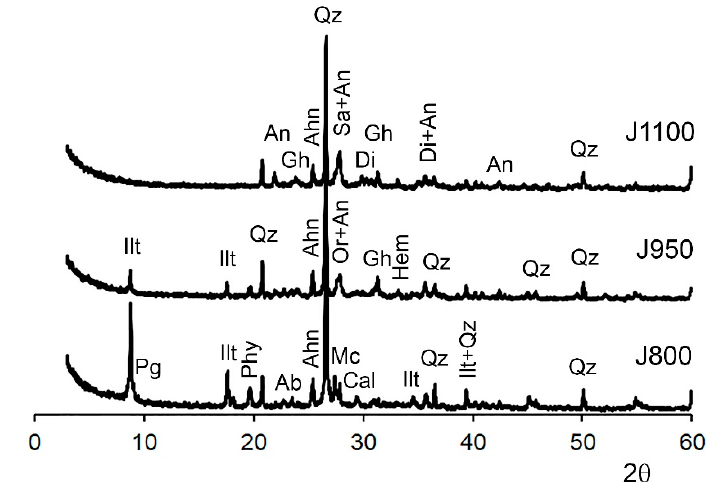
Figure 2. X ray diffraction patterns of bricks without additives (J) fired at 800 °C, 950 °C, and 1100 °C. Legend: Qz = quartz, Ilt = illite/muscovite; Pg = paragonite; Phy: phyllosilicates (in general); Cal = calcite; Ahn = anhydrite; Hem = hematite; Mc = microcline; Or = orthoclase; Sa = sanidine; Ab = albite; An = anorthite; Gh = gehlenite; Di = diopside. Minerals abbreviations after Whitney and Evans [55].